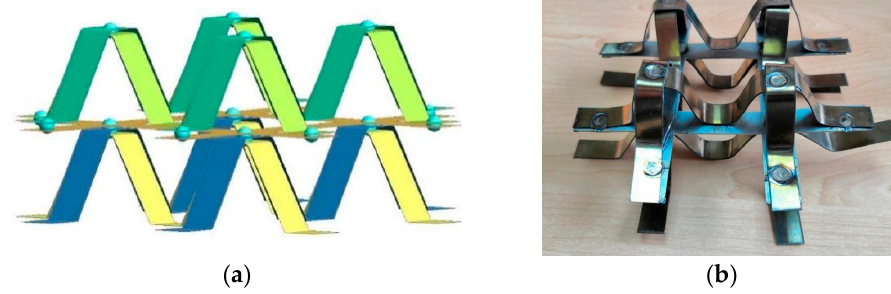
Figure 14. ( a ) After the simulation is completely unloaded, ( b ) Sample of double layer composite module of NiTi SMA. module of NiTi